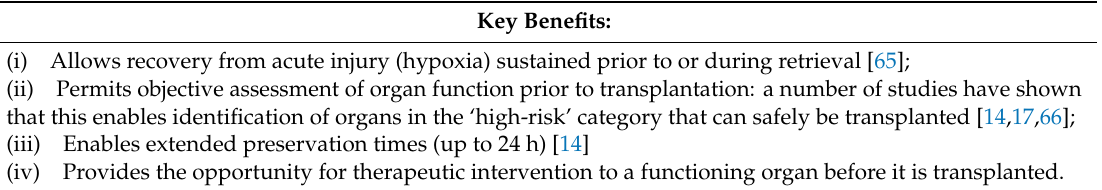
Table 3. Normothermic machine perfusion (NMP) in liver transplantation.